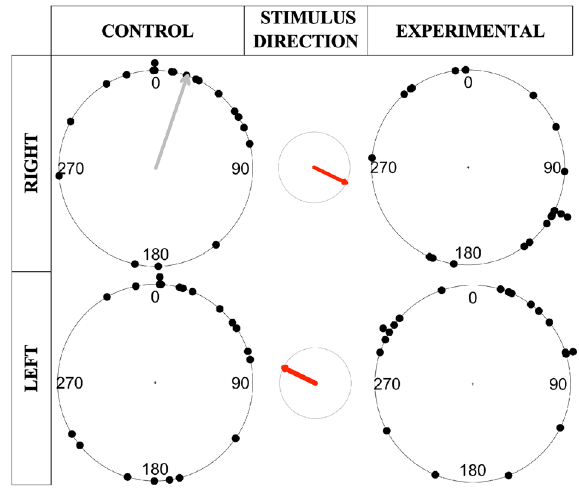
Figure 4. Circular plots of the directions free-roam crabs moved in control vs experimental conditions. Plots display the compass bearing direction of individual focal crabs (each black dot represents a single crab). Data are separated by condition (control or experimental) and stimulus direction (left or right). The red arrow in the center circle displays the stimulus direction. Grey arrow shows mean direction when a significant orientation existed (see Table 1).